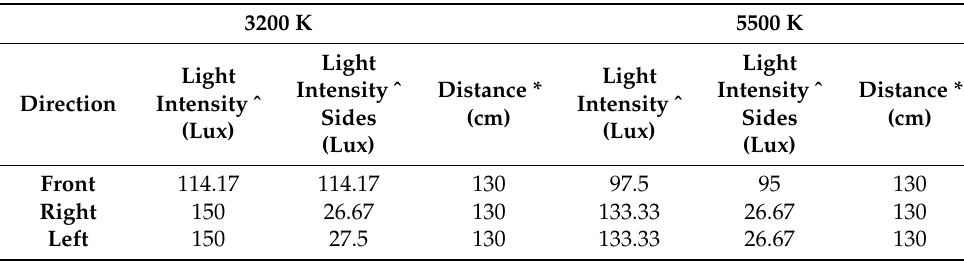
Table 8. Comparison results between the light intensity (Lux) and light color (Kelvin) for a fixed distance of detection of 130 cm for light source with diffuser from front, right, and left side. 3200